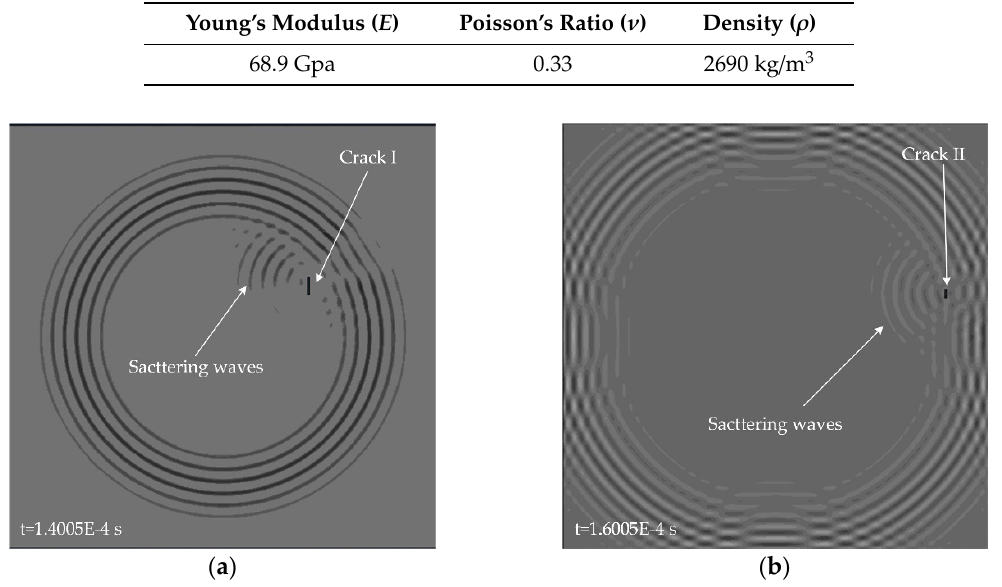
Table 1. Material properties of the experimental aluminum plate.